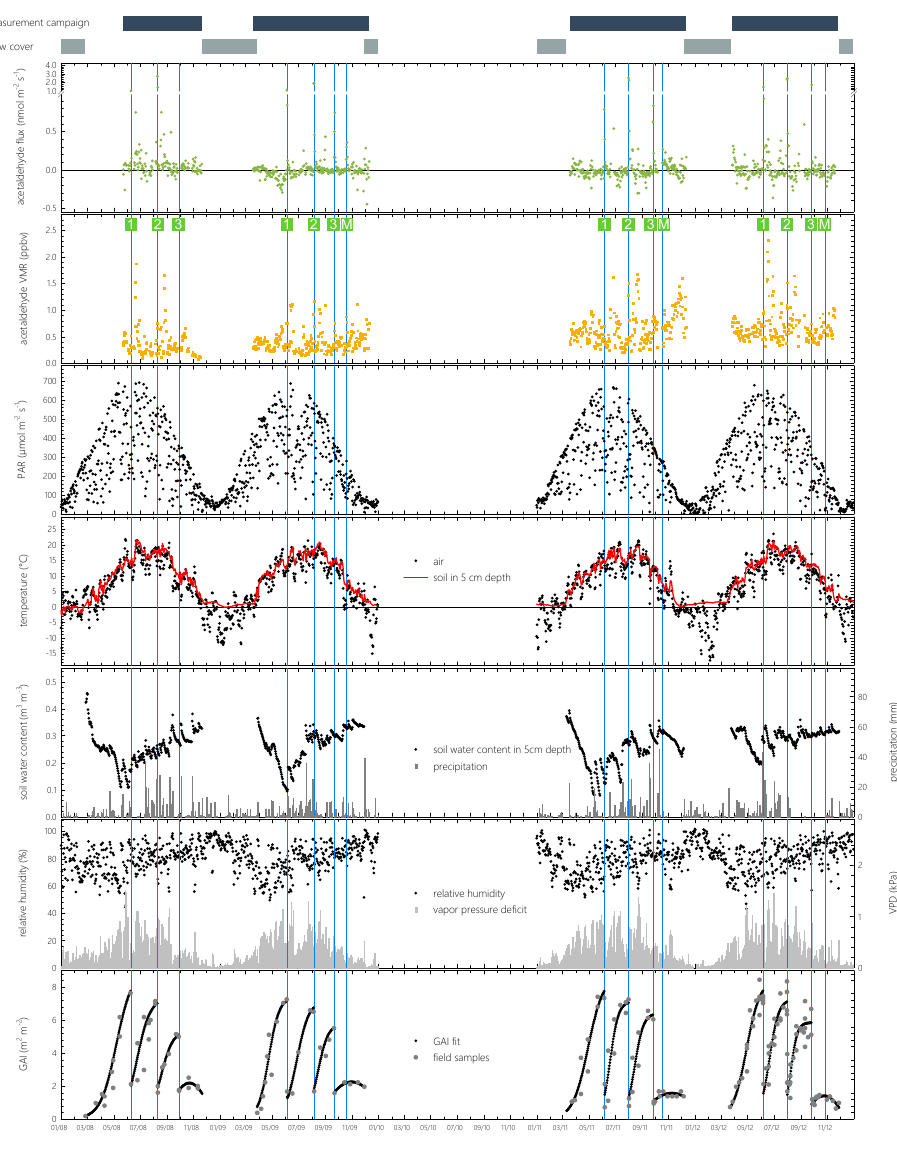
Figure 1. Daily averages of acetaldehyde flux and volume mixing ratio (VMR), photosynthetically active radiation (PAR), air temperature, soil temperature in 5cm depth, soil water content in 5cm depth, relative humidity, vapor pressure deficit, green plant area index (GAI) and daily sums of precipitation over 4 years of VOC measurements from 2008–2009 and 2011–2012. Vertical lines show management dates, numbers 1, 2 and 3 in green squares mark the first, second and third cutting of the meadow, respectively, while M denotes manure